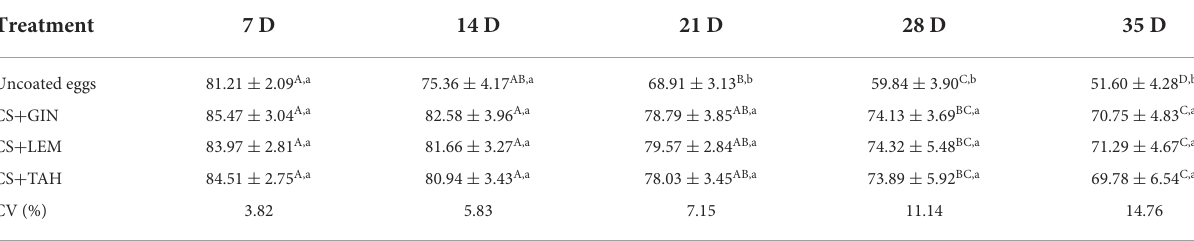
TABLE 1 Haugh unit (HU) of the different treatments during the 35 days of storage at 20 ◦